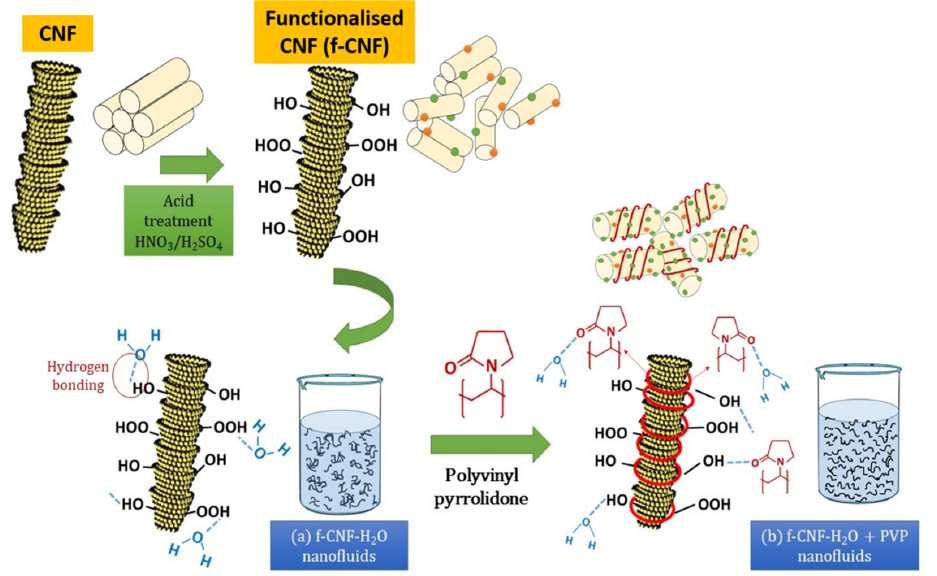
Figure 17. Schematic representation of the surface oxidation and PVP mechanism on the dispersion of CNFs in water ‐ based liquids.